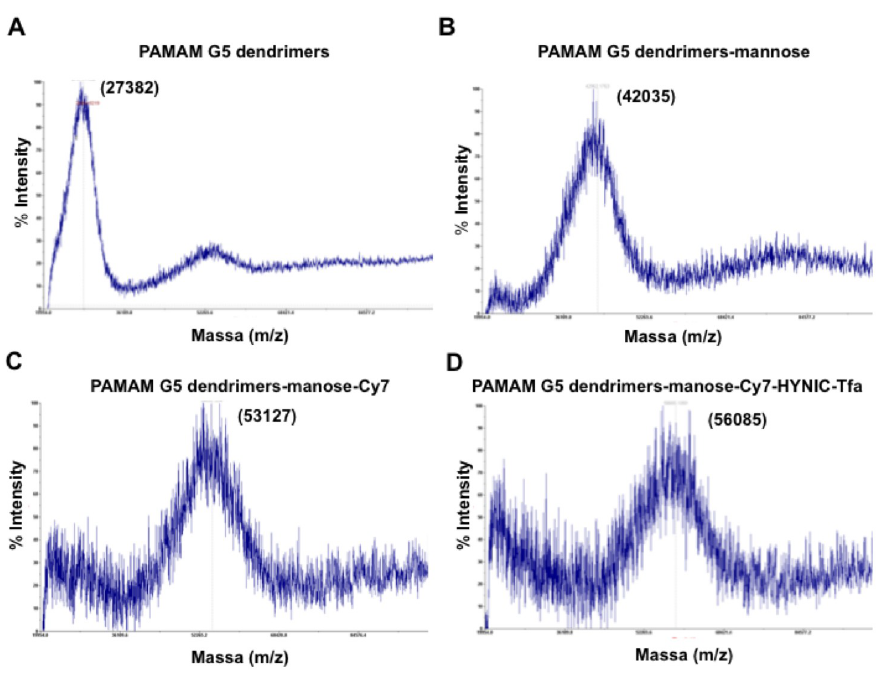
Fig 2. MALDI-TOF MS spectra. (A) PAMAM G5 dendrimers, (B) PAMAM G5 dendrimers-mannose, (C) PAMAM G5 dendrimers-manose-Cy7 and (D) PAMAM G5